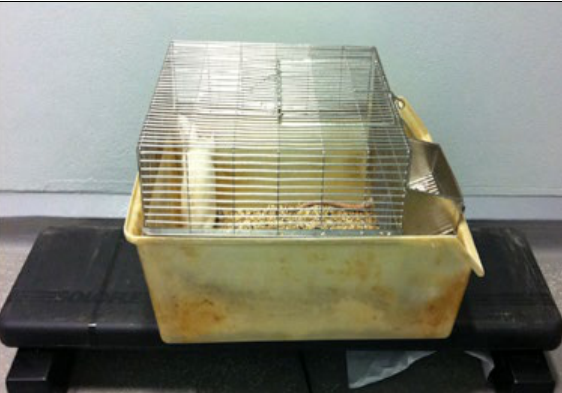
Figure 2. Soloflex whole body vibration platform.